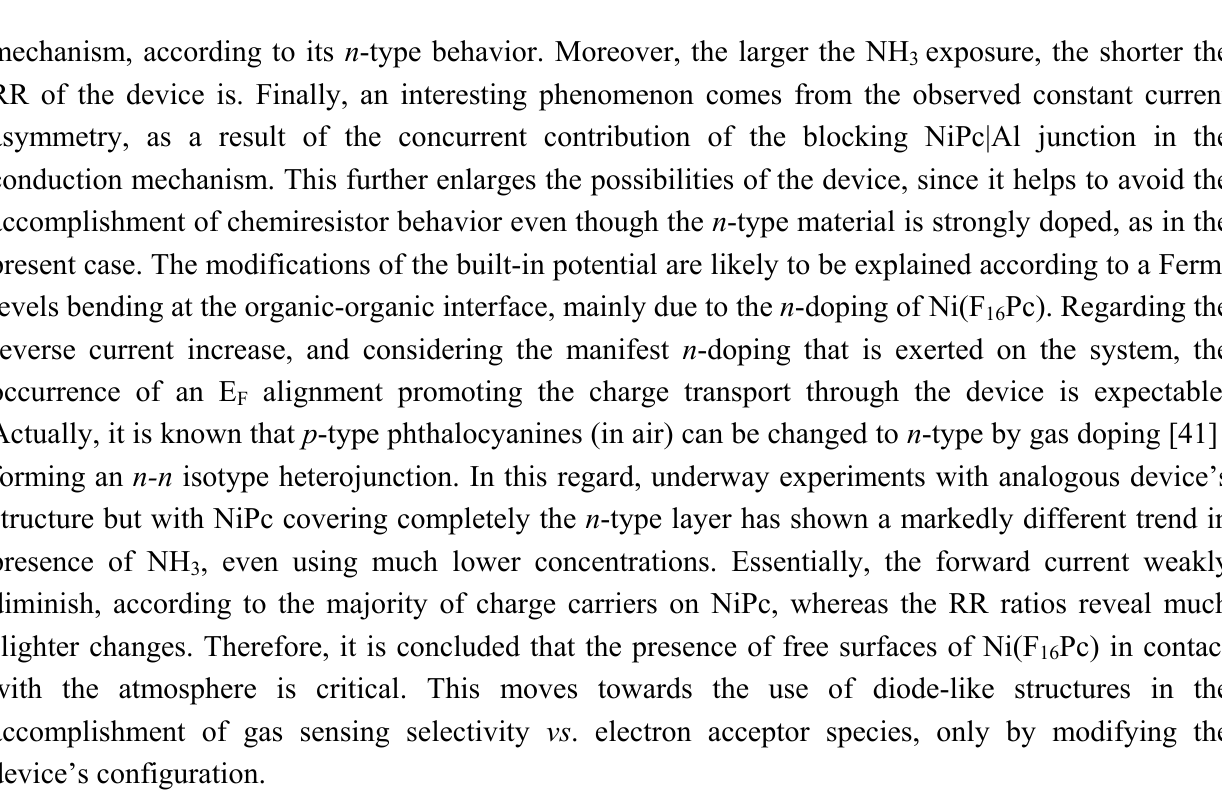
Table 1. List of quantitative values reporting the sensitivity of the bilayer sample when passing -based one during three from an Ar atmosphere to a NH 3